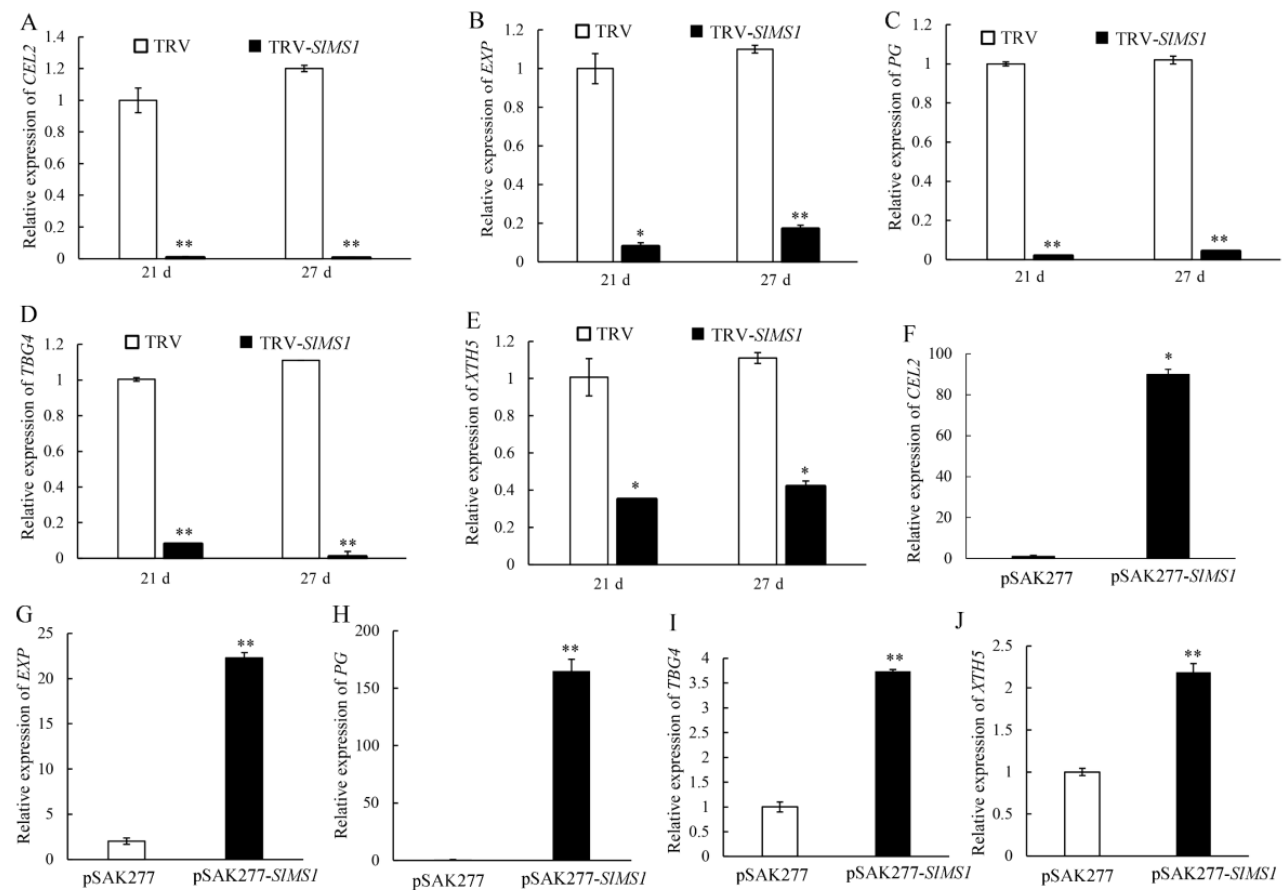
Figure 9. Effect of transient silencing and transient overexpression of SlMS1 on gene expression of cell wall metabolism related genes CEL2, EXP, PG, TBG4 and XTH5 in tomato fruit. ( A – E ) Relative gene expression of CEL2 ( A ), EXP ( B ), PG ( C ), TBG4 ( D ) and XTH5 ( E ) in control (TRV) and SlMS1 -silenced fruit (TRV- SlMS1 ) at 21 and 27 days post inoculation. ( F – J ) Relative gene expression of CEL2 ( F ), EXP ( G ), PG ( H ), TBG4 ( I ) and XTH5 ( J ) in control (pSAK277) and SlMS1 -overexpressed (pSAK277- SlMS1 ) fruit at 10 days post inoculation. The symbols * and ** stand for p < 0.05 and p < 0.01, as determined by Student’s t -test, respectively.